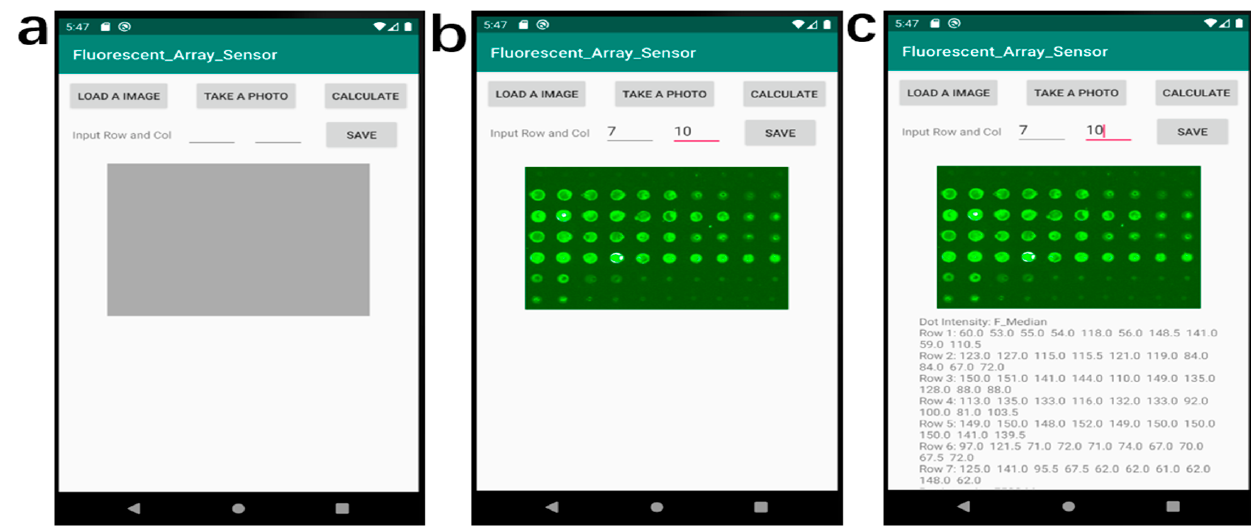
Figure 2. The image processing flow of the smartphone Fluorescent_Array_Sensor application. ( a ) The home page of the application. ( b ) The snapshot of the work page after loading an image and inputting the values of rows and columns. ( c ) The snapshot of the work page after calculating the data values.